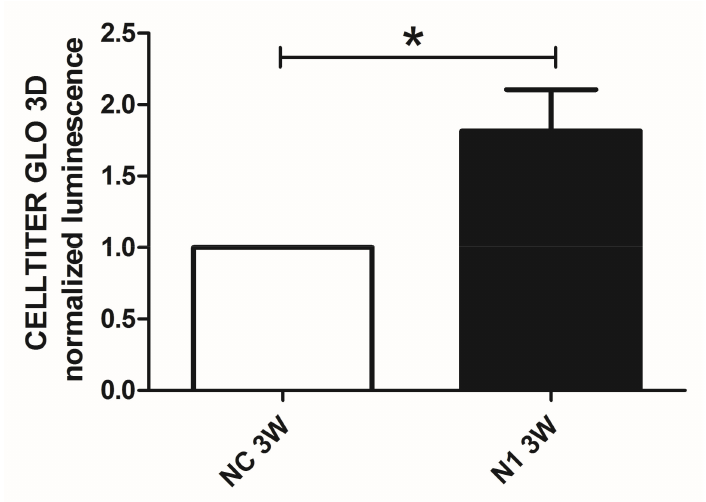
Figure 7. Effects of NOTCH1 silencing in the long term viability of chondrocytes cultured in 3-D. Assessment of cell viability in 3 week micromasses by means of the Cell Titer GLO 3D cell viability assay. N1 samples exhibited a statistically significant increased viability compared to NC. Data represent N1 luminescence normalized as fold change compared to NC values and are expressed as mean ± SD ( n = 3). Statistical analysis was performed by Student’s t test for paired samples; * p <